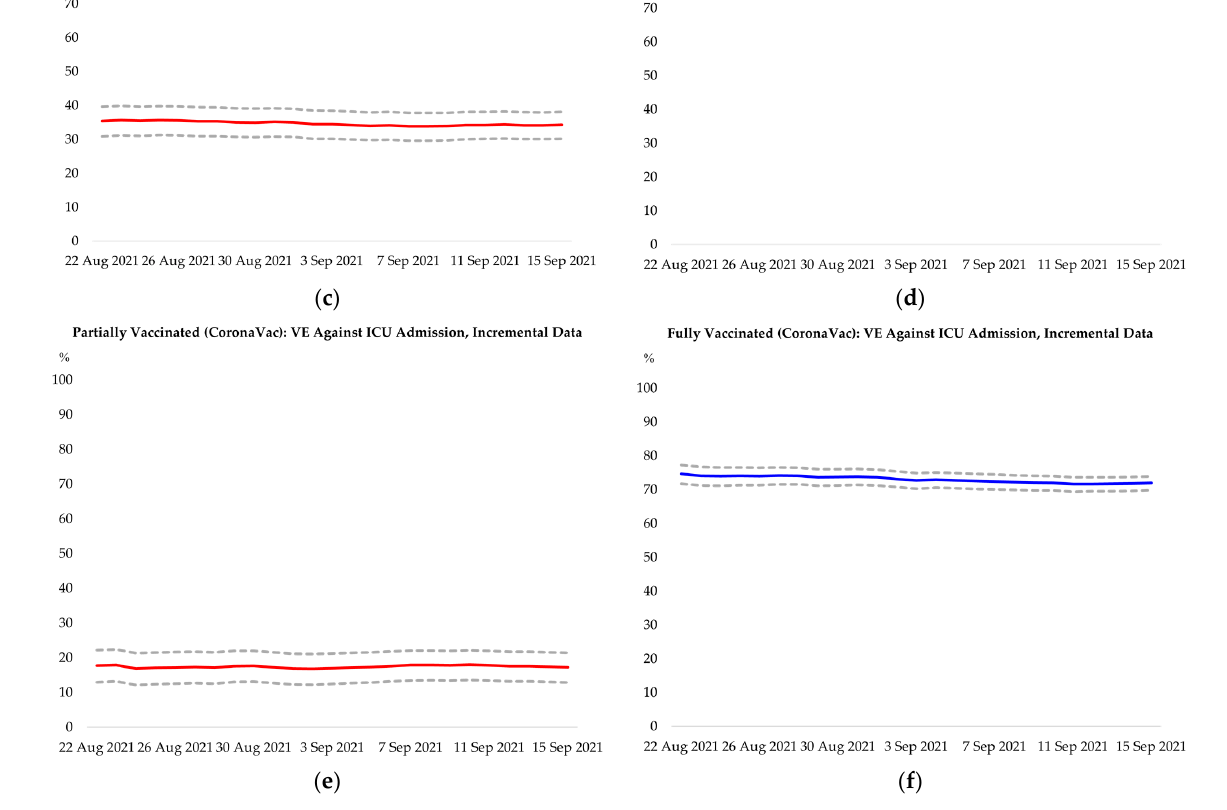
Figure A2. Robustness check for the overall effectiveness of partial and full vaccination by vaccine type over the study period, with line plots representing the effectiveness for COVID-19-related ICU admission estimated with data from 1 April 2021 up to the corresponding day on the horizontal axis; dotted lines show the 95% confidence interval. ( a ) Effectiveness of partial vaccination against ICU admission for AZD1222; ( b ) Effectiveness of full vaccination against ICU admission for AZD1222; ( c ) Effectiveness of partial vaccination against ICU admission for BNT162b2; ( d ) Effectiveness of full vaccination against ICU admission for BNT162b2; ( e ) Effectiveness of partial vaccination against ICU admission for CoronaVac; ( f ) Effectiveness of full vaccination against ICU admission for CoronaVac.